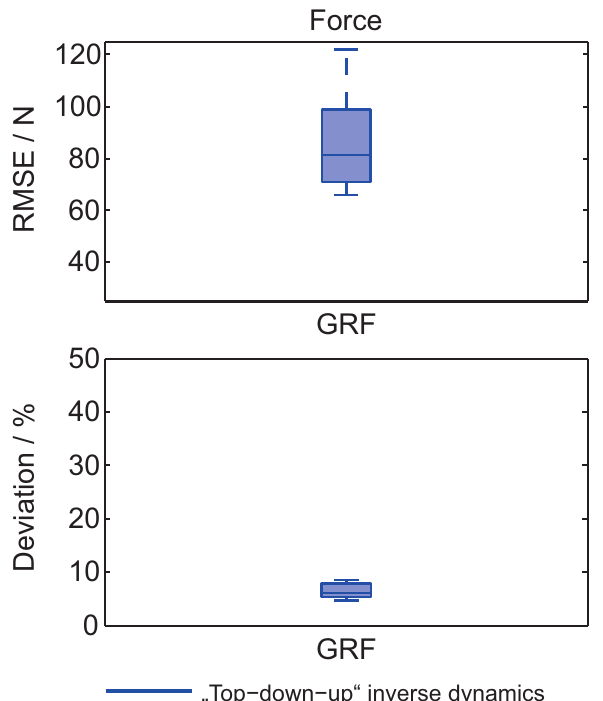
Figure 9. RMSE and calculated deviation of GRF for the top-down-up inverse dynamics based on the reference value. Measurements were performed during the outdoor experiment on the ski hill. The middle line, the bottom and the top of the box present the median, 25th and 75th percentiles, respectively. The whiskers present the furthermost value in the 1.5 interquartile